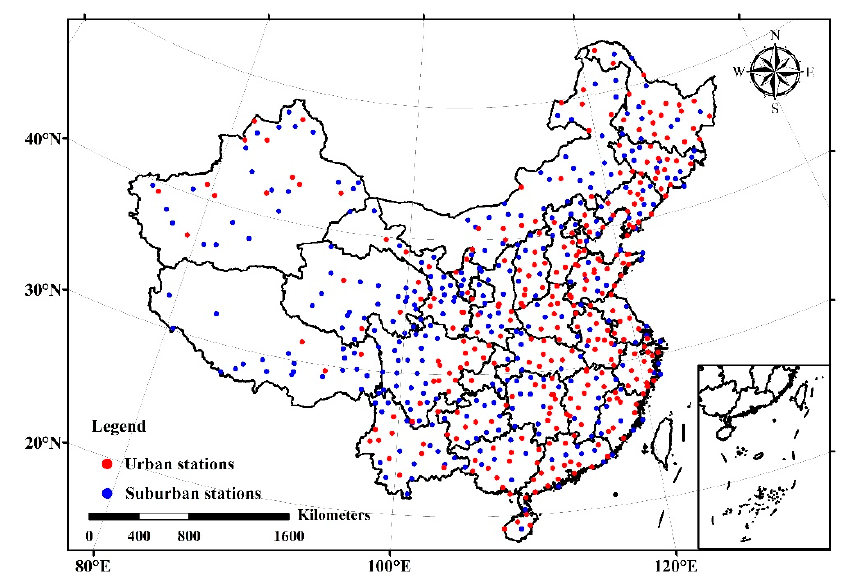
Figure 1. Distribution of national meteorological stations.